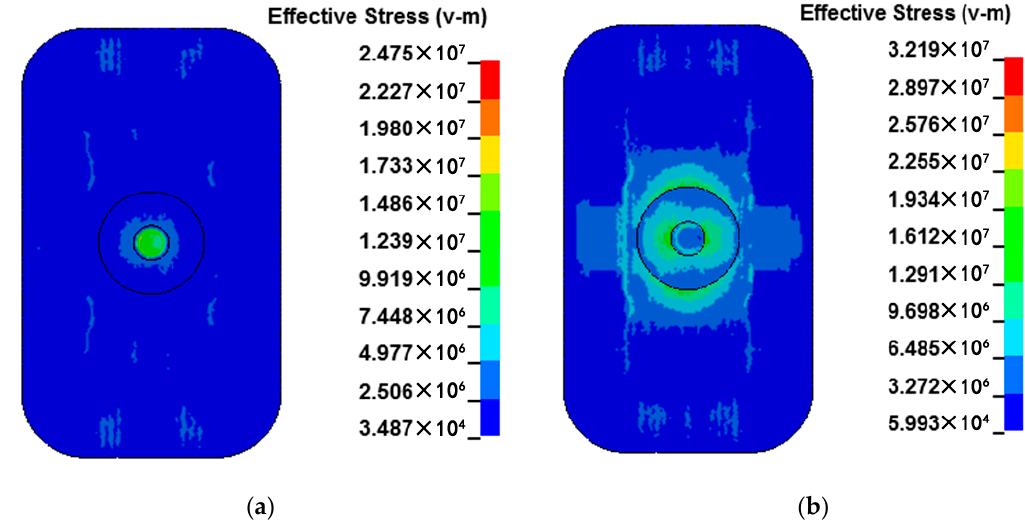
Figure 15. Distribution of plate stress under 50 Hz. ( a ) plate stress distribution at the maximum of upper half cycle. ( b ) plate stress distribution at the maximum of lower half cycle.